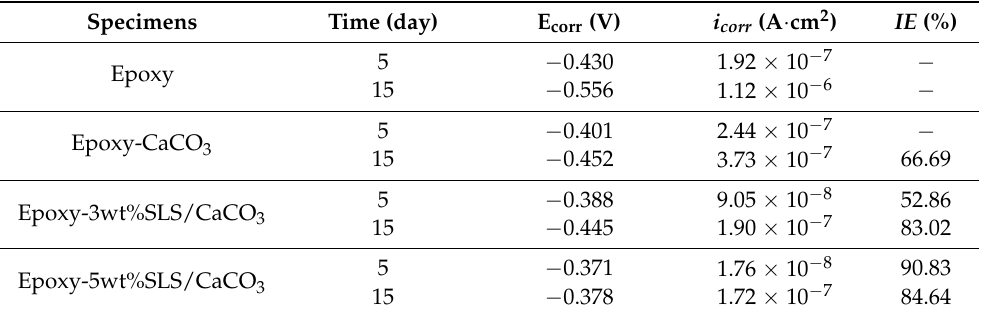
Table 3. Polarization parameters of the applied coatings in the SCP